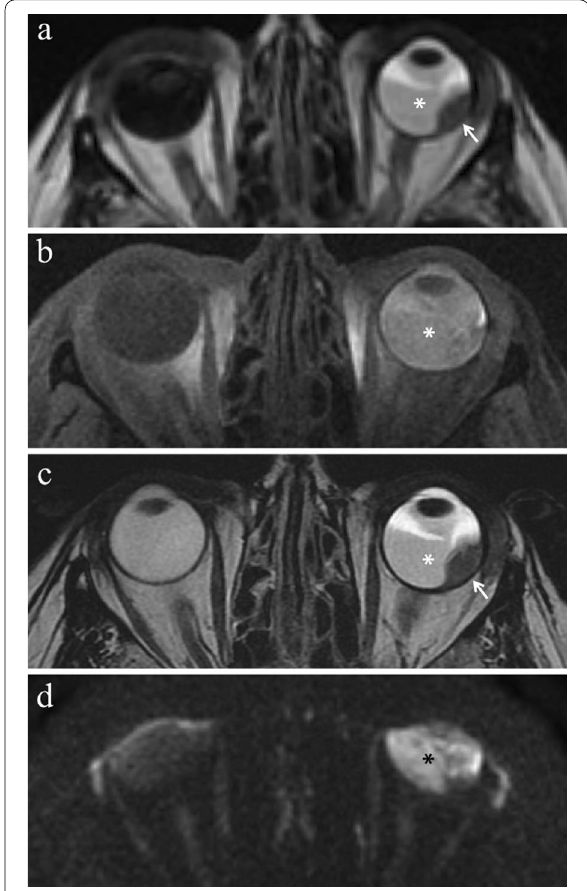
Fig. 12 A 75-year-old woman with radiation-induced vitreous hemorrhage after proton-beam radiotherapy for choroidal melanoma of the left eye. The patient underwent secondary enucleation one year after radiotherapy because of painful eye. Axial ( a ) T2-weighted FLAIR (from brain MRI scan), b fat-suppressed T1-weighted, c T2-weighted turbo spin-echo and ( d ) DW (b 1000 s/mm 2 ) = images. The anterior chamber and the vitreous body of the left eye demonstrate inhomogeneous high signal intensity on T2-weighted FLAIR and T1-weighted images (white asterisks). On T2-weighted image, an intraocular fluid–fluid level, with relative hypointensity of the declivous portion (white asterisk), is recognizable within the left globe. Note the difference with the physiological water-like signal intensity of the contralateral eye. On DW image, the left vitreous body exhibits restricted diffusion with high signal intensity (black asterisk). The findings are consistent with extensive vitreous hemorrhage. A dome-shaped intraocular lesion (white arrows in a and c ) is recognizable along the lateral aspect of the left